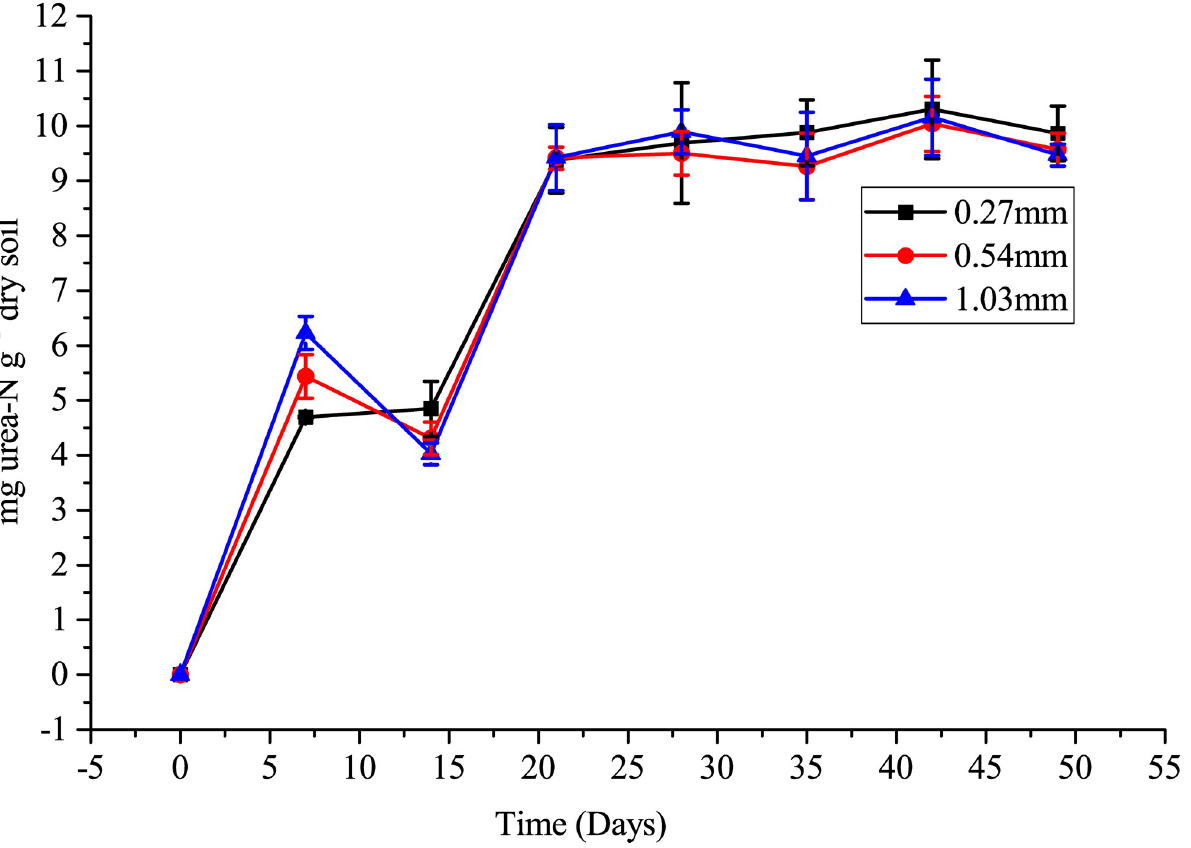
Fig 5. Thickness of SRF films’ effect on the urea release over time.